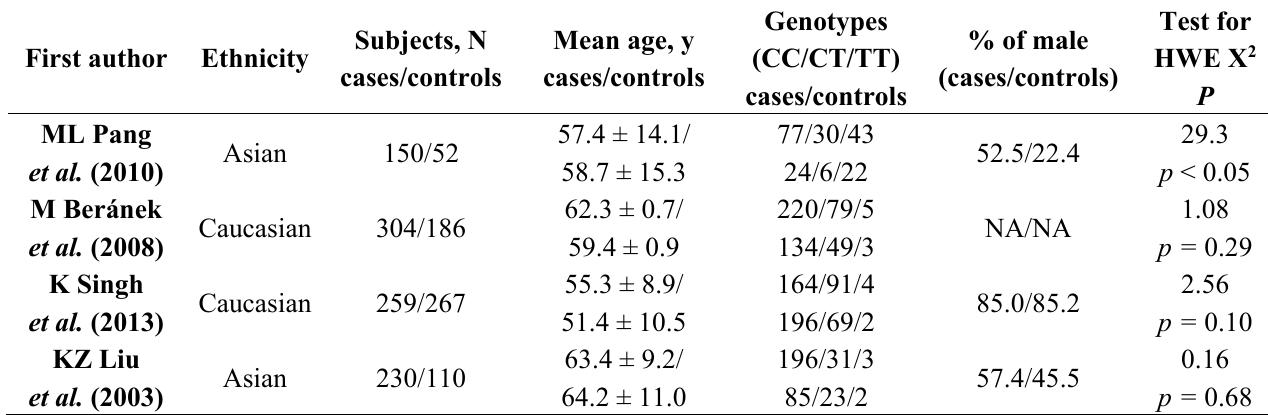
Table 1. Main characteristics of the studies included in the